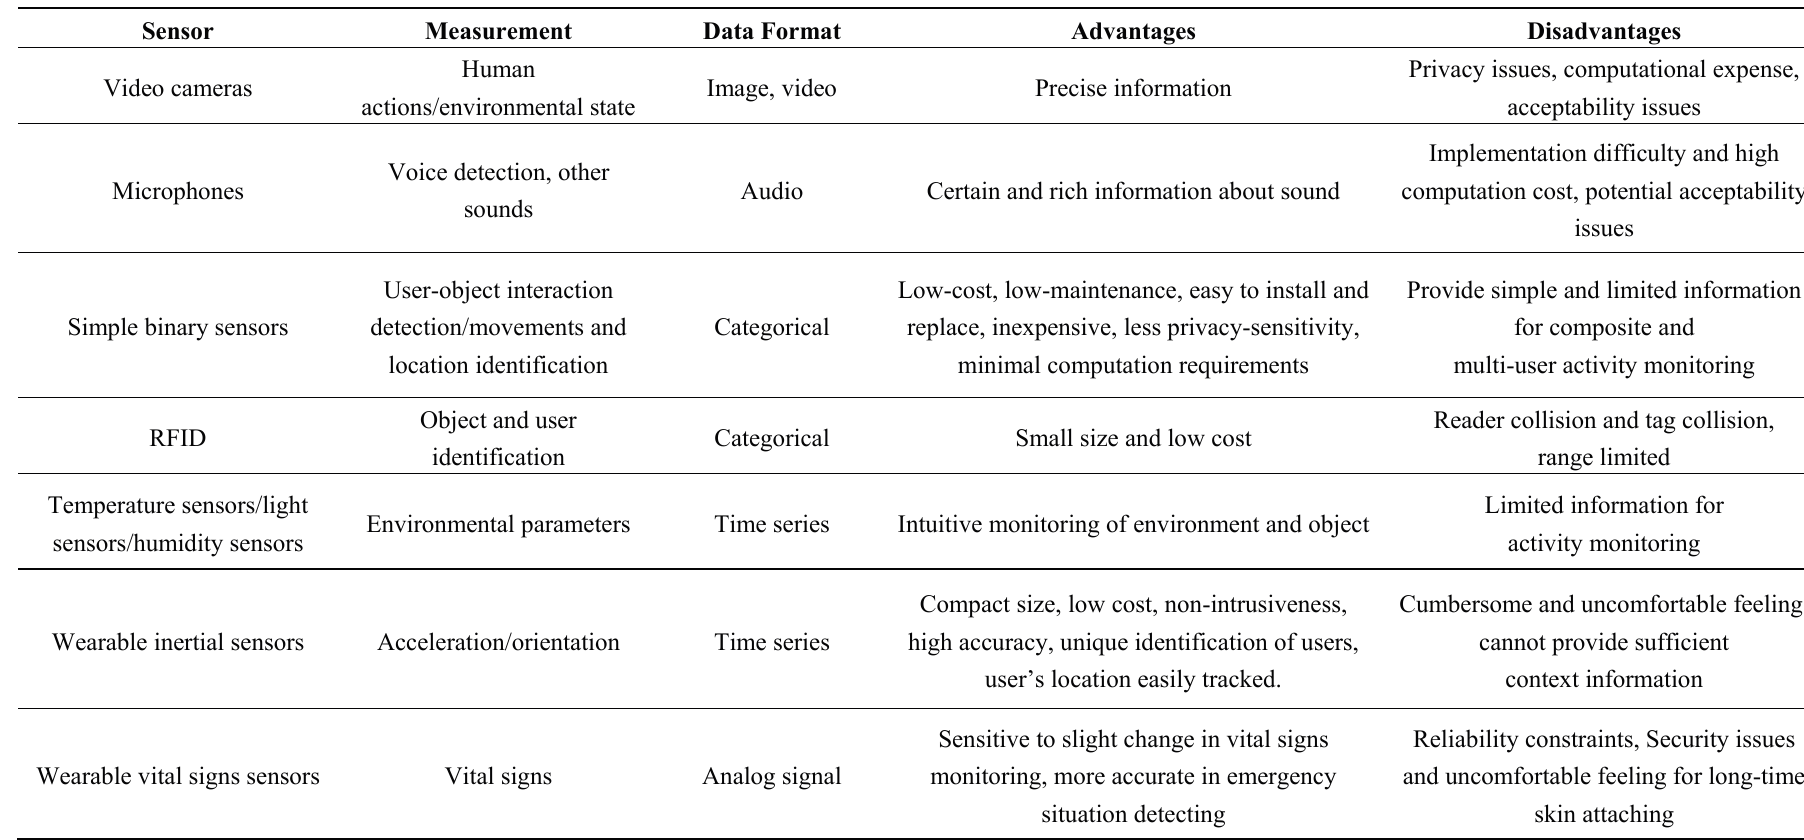
Table 4. Sensors in the smart home: summary of main characteristics relevant to activity